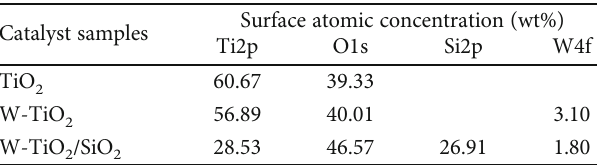
Table 2: Surface atomic concentration (wt%) obtained from XPS analysis. Catalyst samples